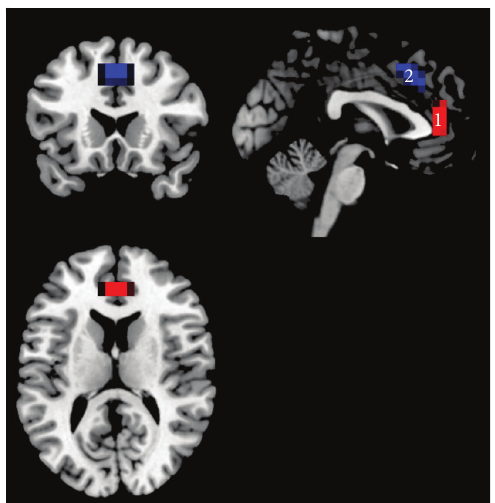
Figure 1: Seed ROIs used for RSFC analysis. ROI1: pregenual ACC (pgACC) as marked in red color. ROI2: dorsal ACC (dACC) as marked in blue color overlaid on the T1 anatomical MNI